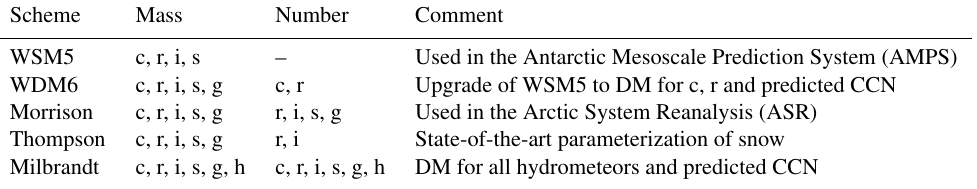
Table 2. Microphysics schemes of WRF (version 3.5.1) used in this work with their predicted cloud variables. DM stands for double-moment scheme (see text for details). All prognosed hydrometeor variables are designated by letters as follows. c: clouds droplets; i: ice crystals; r: rain drops; s: snow crystals; g: graupel; h: hail. The Morrison scheme can be used as a double-moment scheme for droplets only when WRF is used with WRF-Chem. See text for the references related to the cloud microphysics